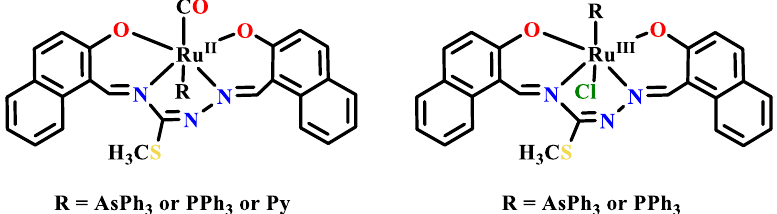
Figure 35. Ruthenium complexes of dinaphthylhydrazone ligands reported by R. Prabhakaran’s group ( left ) and Sellappan Selvamurugan’s group ( right ).